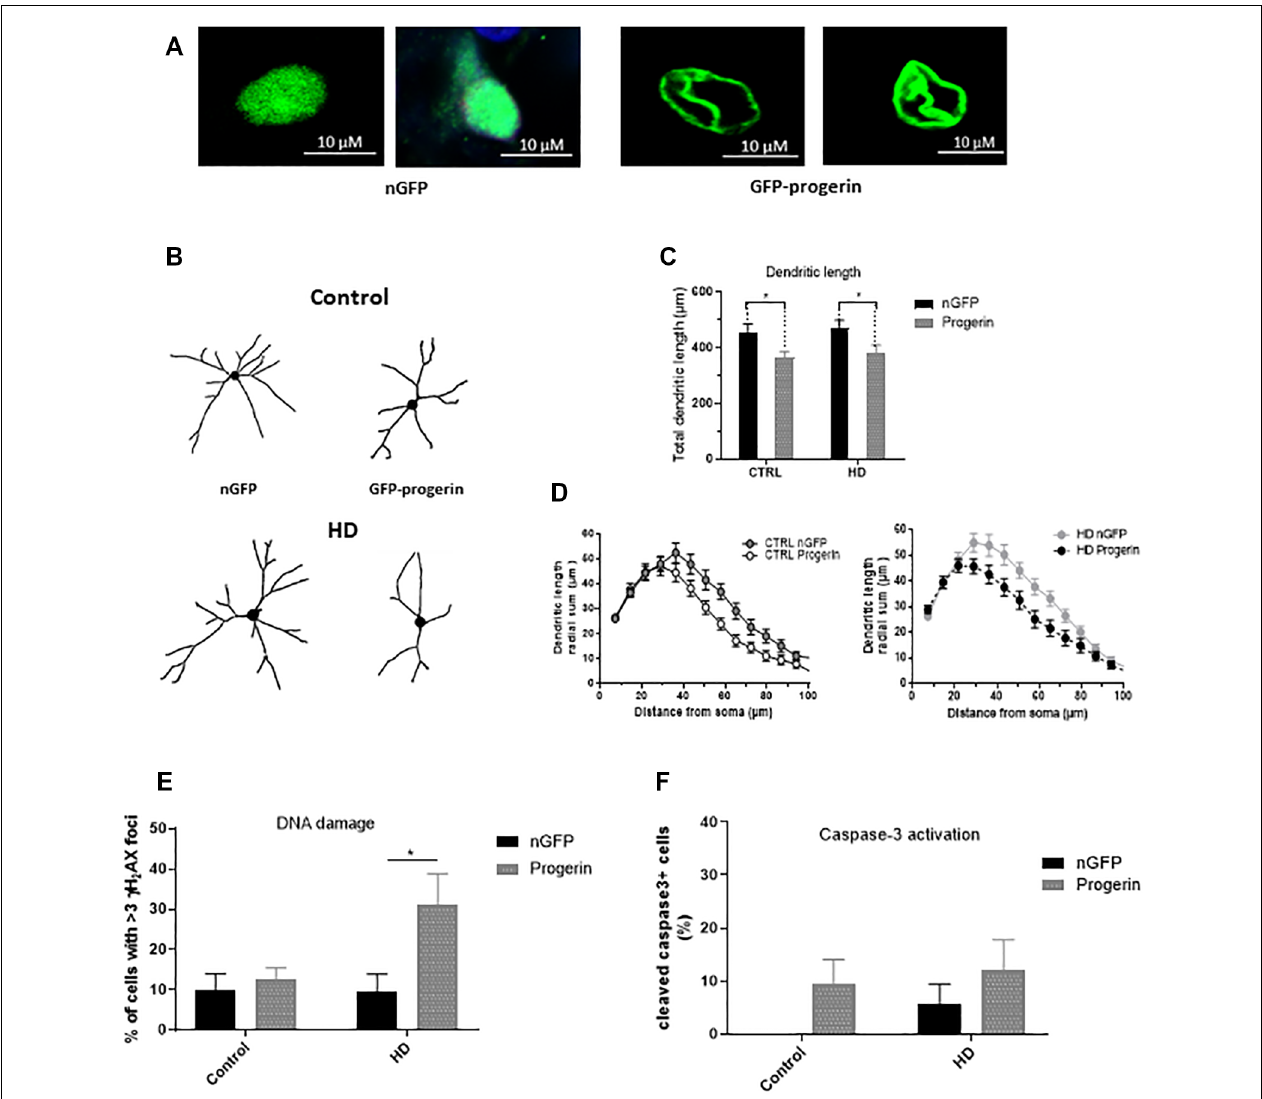
FIGURE 6 | Progerin treatment induces age-related changes and enhances HD-like phenotypes in HD induced pluripotent stem cell (iPSC) derived neurons. HD patient and healthy control iPSCs were differentiated toward striatal-like neurons and treated with nGFP or progerin and evaluated by immunocytochemistry. (A) GFP staining demonstrates nuclear blebbing in progerin, but not nGFP treated neurons. (B–D) Dendritic morphology was assessed in transduced cells by (C) total dendrite length and (D) radial dendritic complexity. (E) Apoptosis was assessed by % of transduced neurons that are caspase-3 positive. (F) DNA damage was assessed by % of transduced neurons with >3 γ H 2 AX foci, revealing a selective increase in HD neurons. *Difference between indicated bars. * p < 0.05. Error bars ±